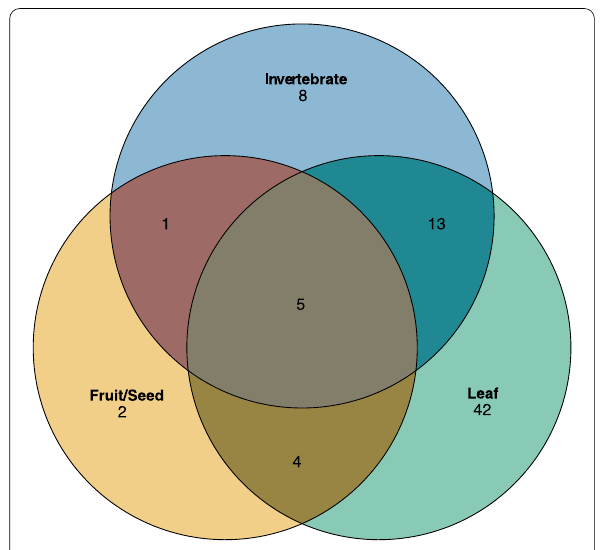
Fig. 1 Venn diagram of overlapping core taxa with relative abundance no less than 0.1% and present in 75% of the samples among dietary